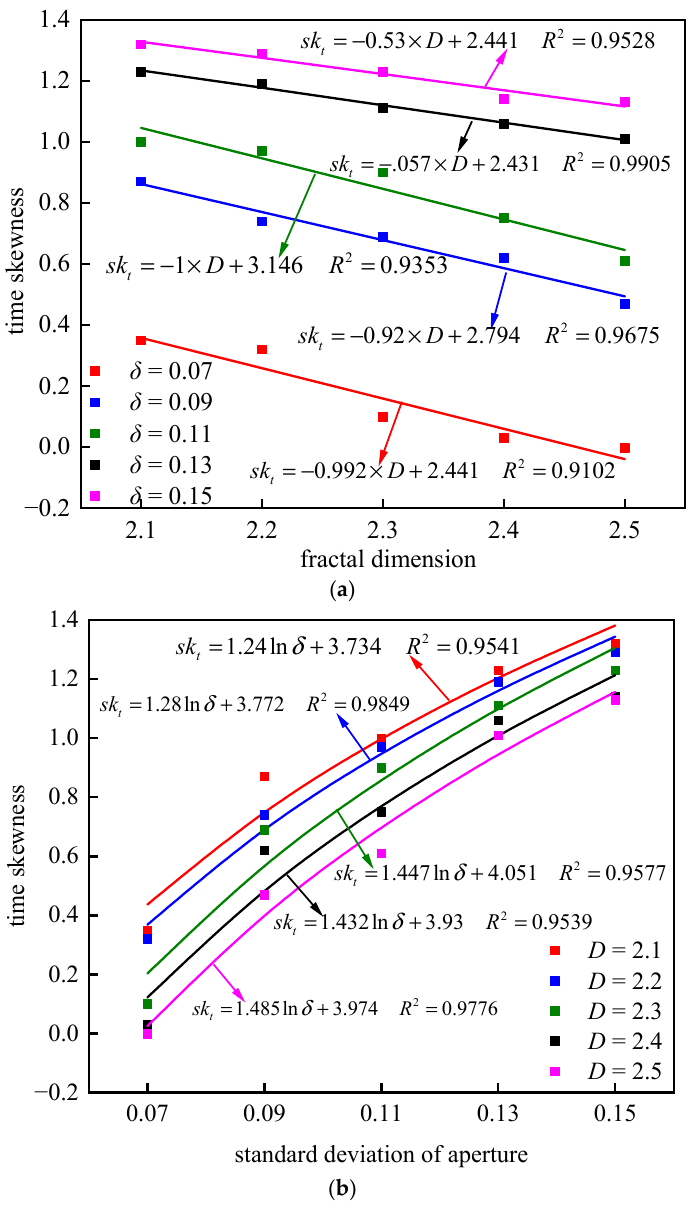
Figure 10. ( a ) Skewness versus fractal dimension; ( b ) skewness versus standard deviation of aper- ture.